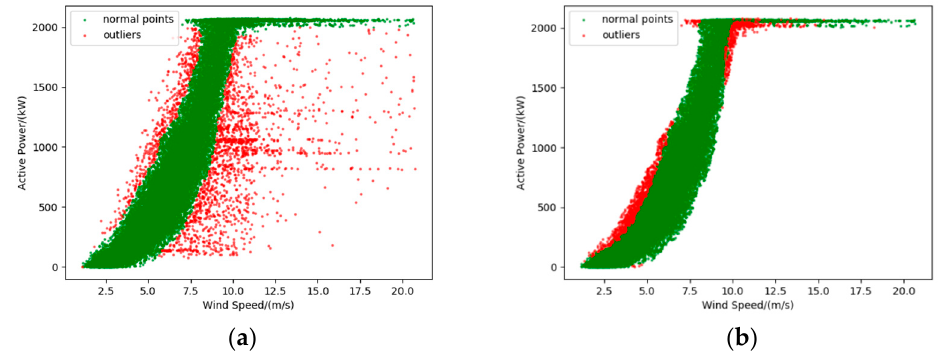
Figure 6. Performance of the proposed data preprocessing method: ( a ) result of the DBSCAN and ( b ) result of the quartile method after filtered out by the DBSCAN.